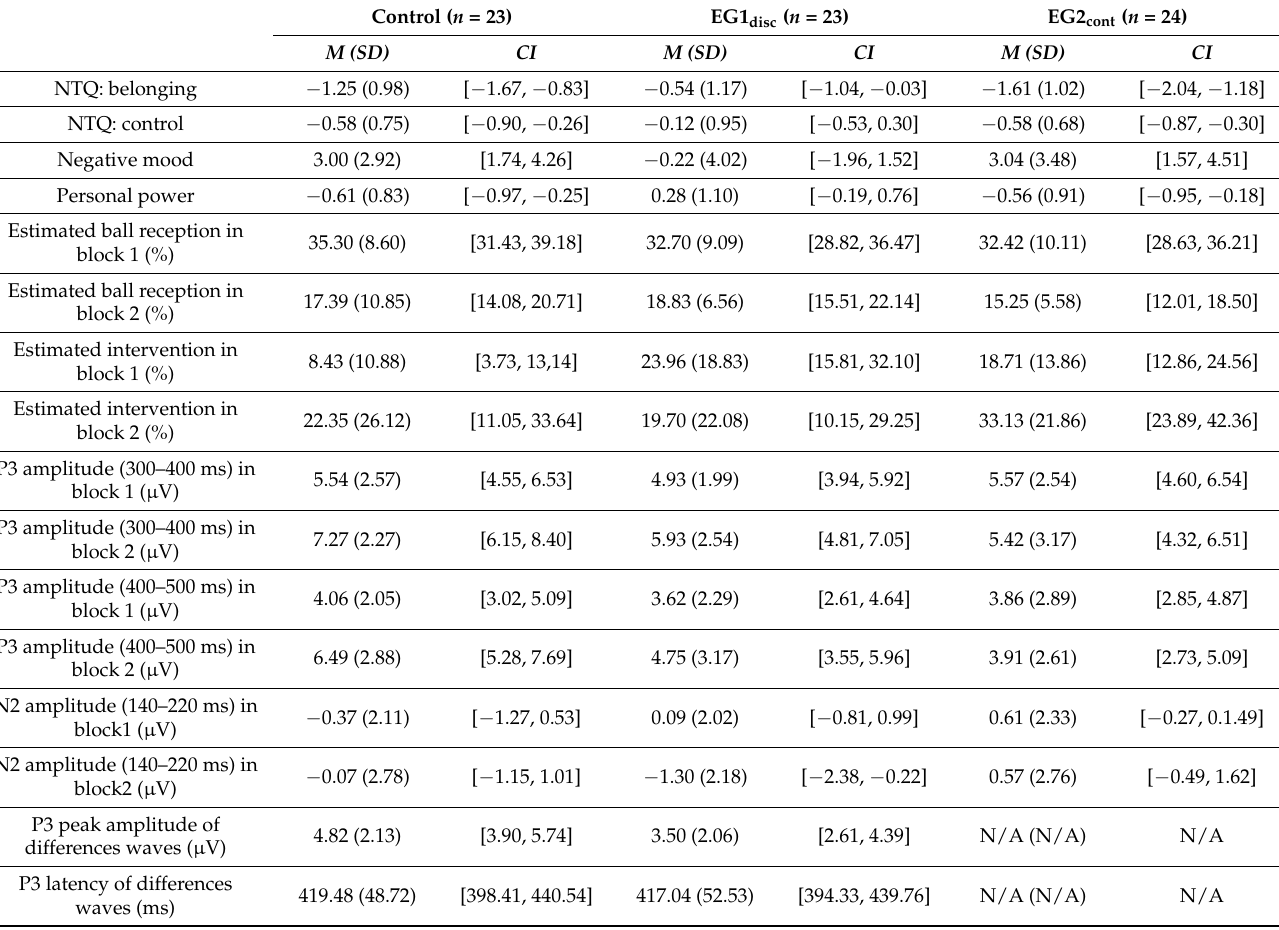
Table 1. Descriptive statistics of the self-report (lines 1–8) and ERP data (lines 9–16). To each mean, the upper and lower confidence intervals (95%) are provided. The negative signs of NTQ mean values indicate that participants feel more threatened in block 2 than in block 1. Mean ERP data are provided for the centro-parietal cluster (P3: Cz, Pz, P7, and P8; N2: Cz and